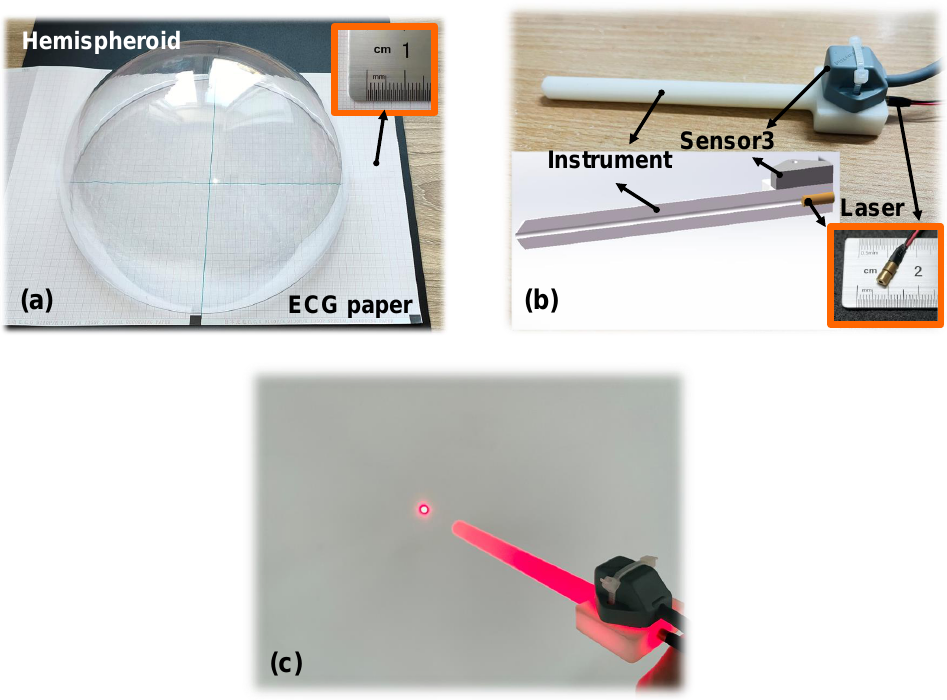
Figure 7. ( a ) Photograph of the hemispherical shell with ECG paper. ( b ) Custom-designed component that imitates an instrument. ( c ) Laser source passing through the instrument form a laser